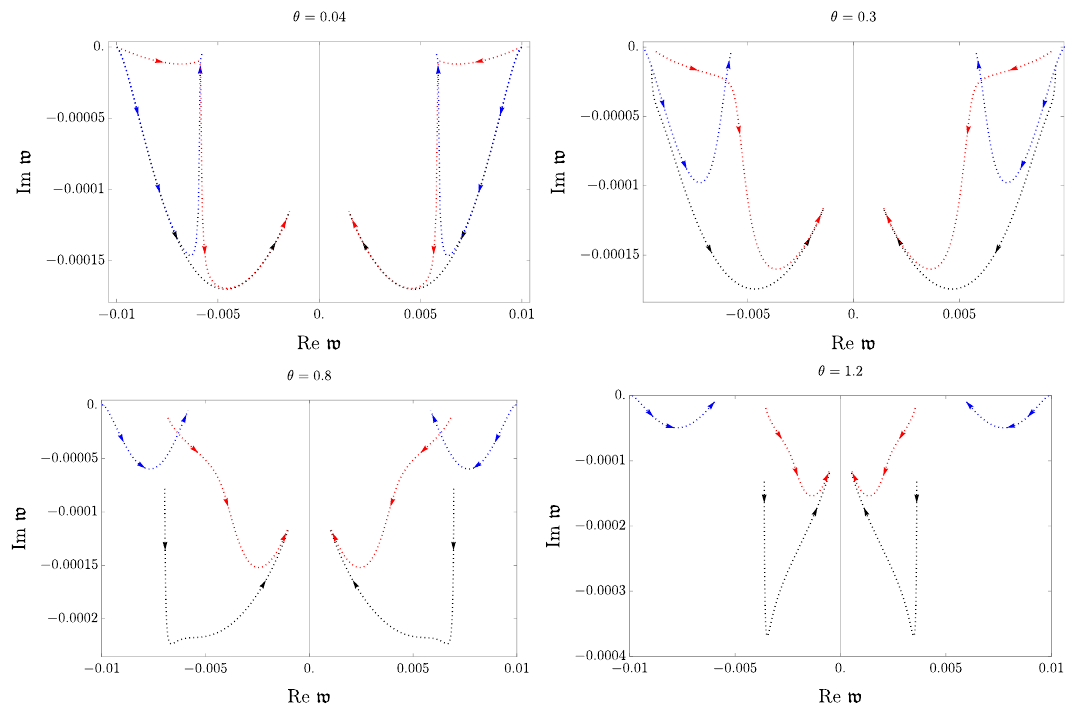
p p B on T= B , plotted for